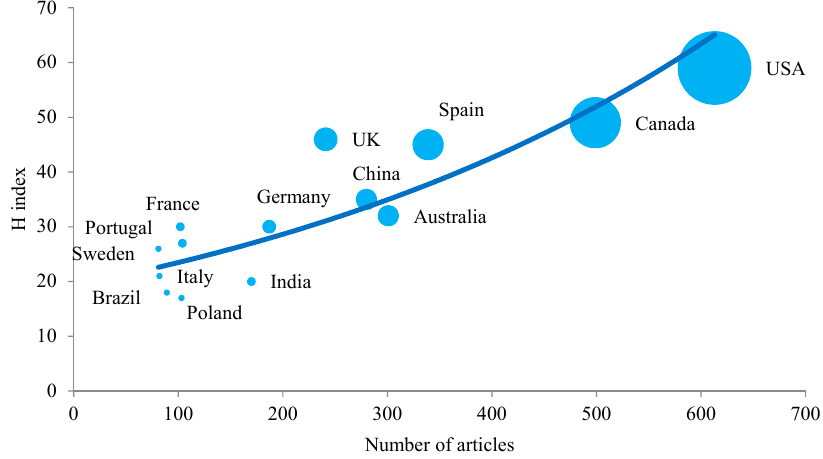
Figure 3. Correlation between H index and the number of articles by country in MW research.